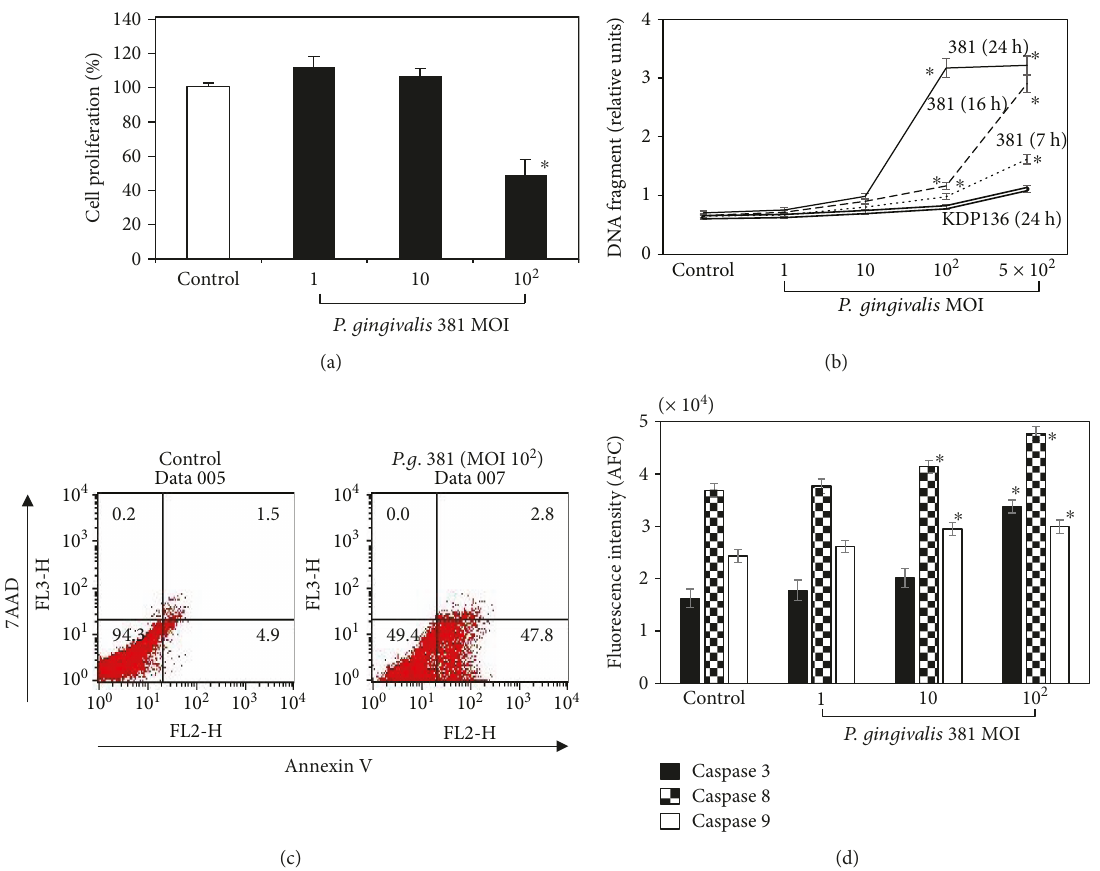
Figure 1: P. gingivalis infection inhibits cellular proliferation and induces apoptosis in HUVEC. (a) HUVEC were treated with P. gingivalis 381 at an MOI of 1 :1 – 1:10 2 for 21h. Cell viability was determined using a Cell Counting Kit-8 (CCK-8). The data are expressed as the mean ± SEM of 3 di ff erent experiments. ∗ p < 0 05 versus bacteria-free control cells. (b) HUVEC were treated with P. gingivalis 381 at an MOI of 1 :1 – 1:5 × 10 2 for 7, 16, and 24h, and with KDP136 at an MOI of 1 :1 – 1:5 × 10 2 for 24 h. Cellular apoptosis was quanti fi ed by DNA fragmentation using the Cell Death Detection ELISA PLUS Kit as described in Materials and Methods. Data are expressed as the mean ± SEM of 3 di ff erent experiments. ∗ p < 0 05 versus bacteria-free control cells. (c) HUVEC were stained with annexin V-EnzoGold and 7-AAD after treatment with P. gingivalis 381 at an MOI of 1 :10 2 for 21h, and then they were analyzed by fl ow cytometry. The fi gure is representative of three experiments with similar results. (d) HUVEC were treated with P. gingivalis 381 at an MOI of 1 :1 – 1:10 2 for 16 h. Cell extracts were prepared, and caspase activities were measured. Data are expressed as the mean ± SEM of 3 di ff erent experiments. ∗ p < 0 05 versus bacteria-free control